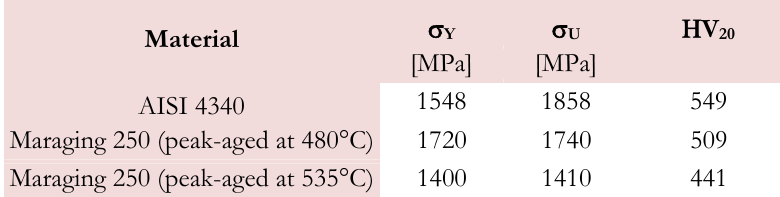
Table 1: Average (3 specimens) yield ( σ Y ) and ultimate strength ( σ U ) for SSRT tested steels.